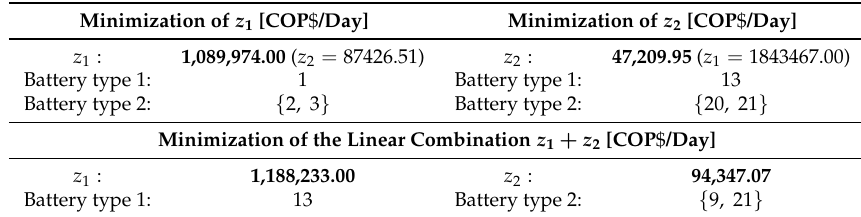
Table 6. Optimal location-reallocation of batteries considering different objective